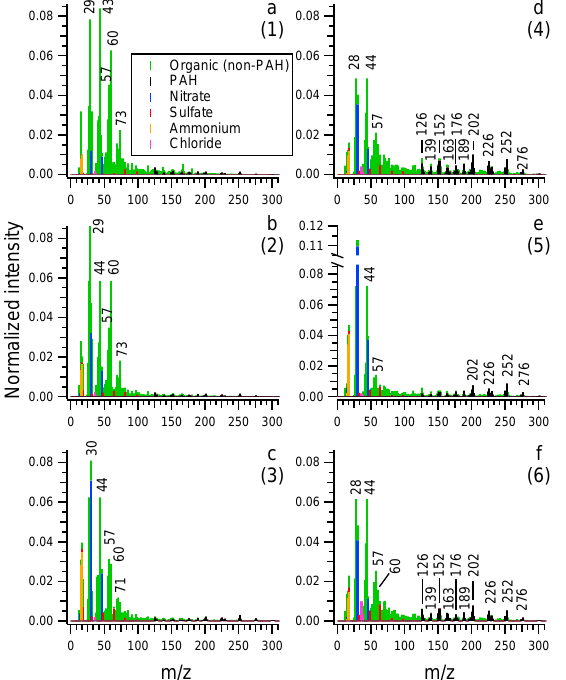
Figure 1. AMS mass spectra of organic (non-PAH) and PAH contri- butions to primary non-refractory particles from (a–c) average-load experiments 1–3 and from (d–f) high-load experiments 4–6, respec- tively. The signal is normalized to the total signal. The legend in (a) applies to (a–f)